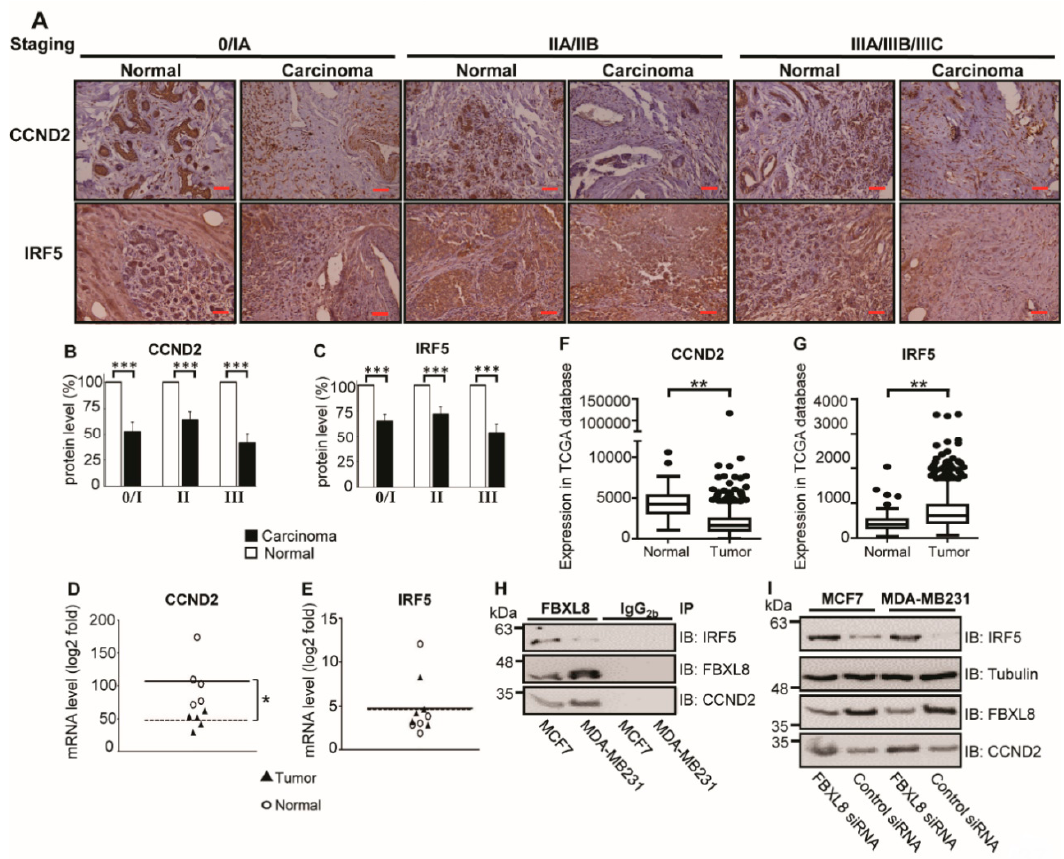
Figure 6. FBXL8 pulled down CCND2 and IRF5, and knockdown of FBXL8 accumulated CCND2 and IRF5 protein levels in BRCA cells. To clarify the potential of CCND2 and IRF5 in primary BRCA tissues, retrospective analyses were performed by IHC (A–C) and NGS-based RNA-Seq (D,E), and from TCGA database (F,G). ( A ) immunofluorescence staining of CCND2 and IRF5. Protein expression levels of CCND2 and IRF5 are examined in both normal ( n = 30) and carcinoma ( n = 30) breast tissues. The corresponding quantitative results of CCND2 and IRF5 in IHC are shown in panels ( B , C ), respectively. ( D , E ) Quantitative results from each patient. Each data point represents a log2 fold change value for CCND2 and IRF5 (*, FDR < 0.05). ( F , G ) Box-whisker plot showing the transcript levels of CCND2 and IRF5 in TCGA database, respectively. Vertical lines, box and horizontal white line correspond to min-max range, 25–75th percentile range and median, respectively. Data are reported as normalized count as provided in the TCGA level 3 data (**, p < 0.01). The corresponding clinicopathological information for IHC are shown in Figure S2. Brown color indicates DAB dye-stained protein of interest. Scale bar is 100 µ m, shown as the red color line (—). ( H ) Co-IP of of FBXL8 and CCND2 (or IRF5) in BRCA cells; total cell lysates were immunoprecipitated with anti-FBXL8 (or control anti-IgG 2b ) antibody, separated by 10% SDS-PAGE (sodium dodecyl sulfate polyacrylamide gel electrophoresis), immunoblotted and probed with FBXL8, CCND2 or IRF5 antibodies. ( I ) To confirm whether CCND2 and IRF5 are regulated by FBXL8-dependent protein degradation, FBXL8 RNAi was performed in MCF7 and MDA-MB231 cells, followed by immunoblotting analysis. Tubulin was used as a loading control for immunoblotting.